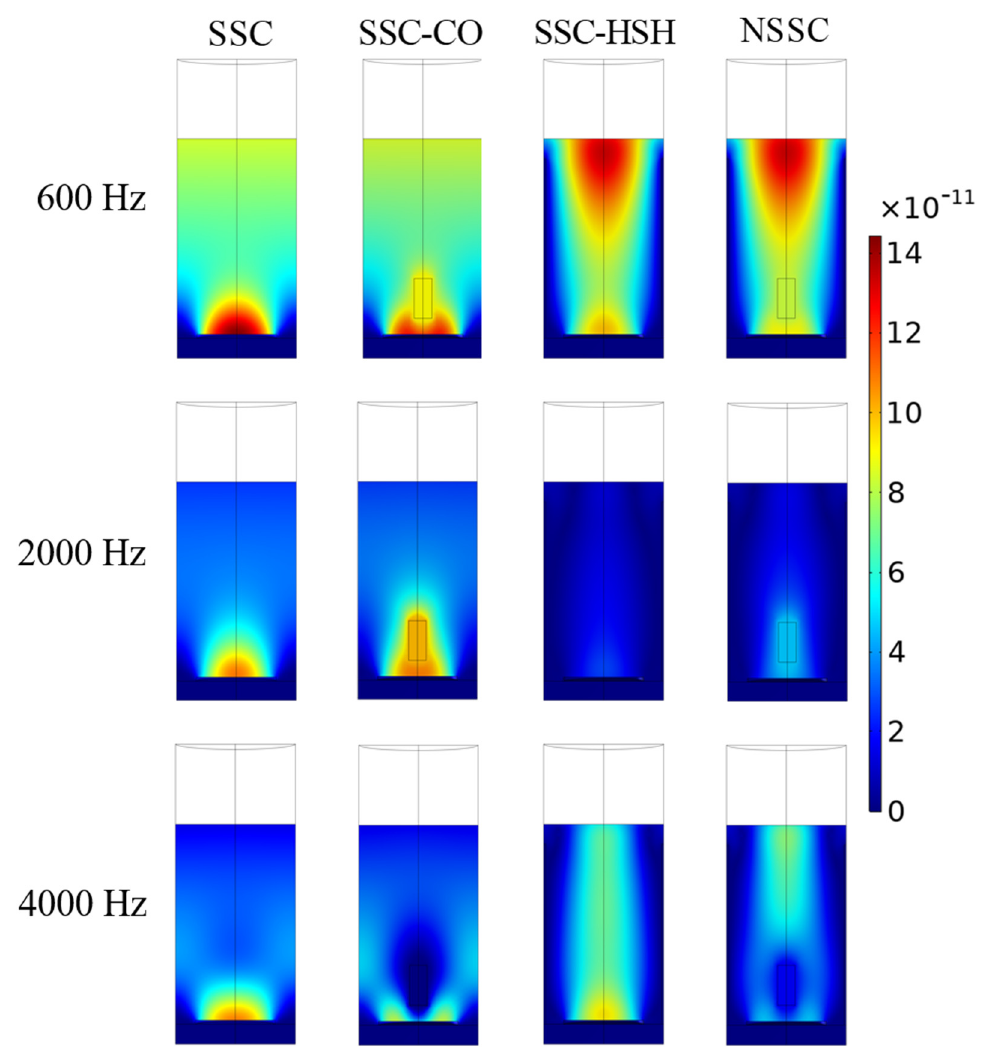
Figure 7. Displacement nephogram of each configuration (unit: m).